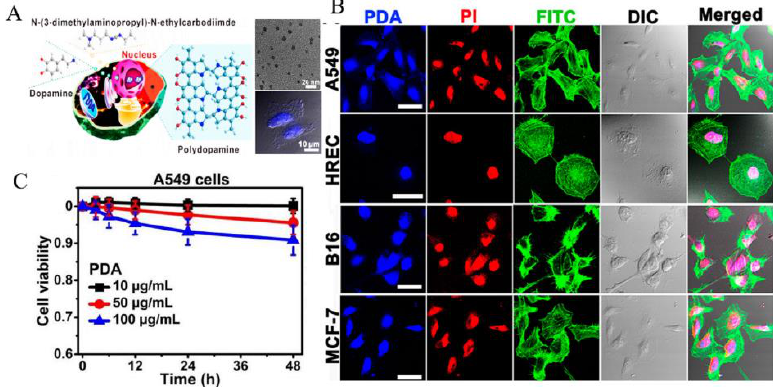
Figure 5. ( A ) Schematic of the preparation of FPDA in cells. ( B ) CLSM. Scale bars = 25 μm ( C ) Cell viability [96]. Reprinted/adapted with permission from Ref. [96]. 2017, American Chemical Society.